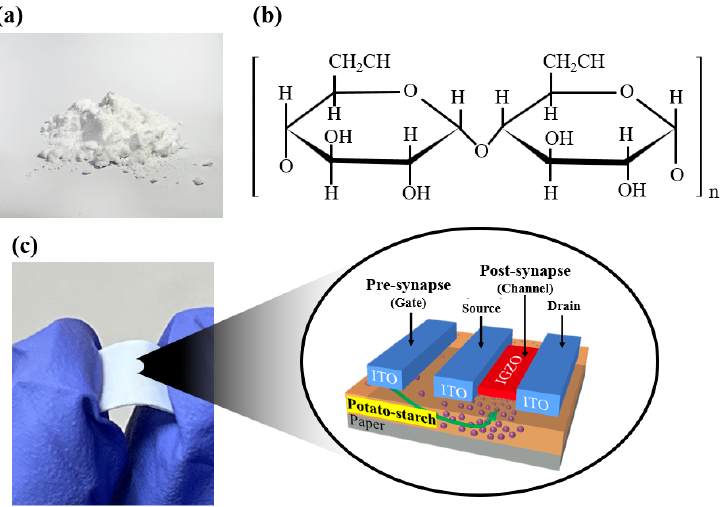
Figure 8. ( a ) Photographic image of potato-starch powder for electrolyte membrane formation of synaptic transistors; ( b ) molecular structure representing repeating units of potato starch. ( c ) Pho- tographic image of the paper substrate on which the synaptic device is formed and a schematic diagram of the fabricated coplanar gate type artificial synaptic transistor. The starting substrate, a photo inkjet printing paper, was blown with nitrogen gas to remove particles from the surface, and then the prepared potato-starch solution was coated onto the substrate using the drop-casting method and dried at room temperature in air for 24 h. An IGZO channel layer with a thickness of 50 nm was deposited on the solidified electrolyte membrane via RF magnetron sputtering at a working pressure, RF power, and Ar flow rate of 6 mTorr, 100 W, and 30 sccm, respectively. Subsequently, 150- nm-thick ITO source and drain (S/D) electrodes and coplanar gates were deposited by RF magnetron sputtering through a shadow mask, with working pressure, RF power, and Ar flow rates of 3 mTorr, 100 W, and 20 sccm, respectively. The sizes of the S/D and coplanar gate electrodes are 1000 × 200 μ m, and the channel width (W) and length (L) are 1000 μ m and 80 μ m, respectively. 3.3. Characterization The chemical groups and molecular structures of the potato-starch electrolyte mem- branes were analyzed using FTIR (IFS66v/s and Hyperion3000, Bruker Optiks, Billerica, MA, USA). The frequency-dependent capacitance of the potato-starch electrolyte-based capacitors was measured with a voltage level of 0.05 V, a current level of 100 μ A, and a delay time of 0.0001 s using an Agilent 4284A precision LCR meter (Agilent Technologies, Santa Clara, CA, USA). Further, an Agilent 4156B semiconductor parameter analyzer was employed to measure the electrical properties and synaptic behavior of the potato starch- based synaptic transistors. In addition, the synaptic behavior was confirmed via the ap- plication of presynaptic spikes using an Agilent 8110A pulse generator. Moreover, all the behavioral characteristics of the synaptic devices were evaluated using a probe station in a dark box to minimize noise interference caused by external electrical signals and light. 4. Conclusions This study fabricated artificial synaptic transistors with coplanar gate structures on paper substrates comprising biocompatible and low-cost potato-starch electrolyte gate in- sulators and indium–gallium–zinc oxide ( IGZO ) channels. The chemical groups and